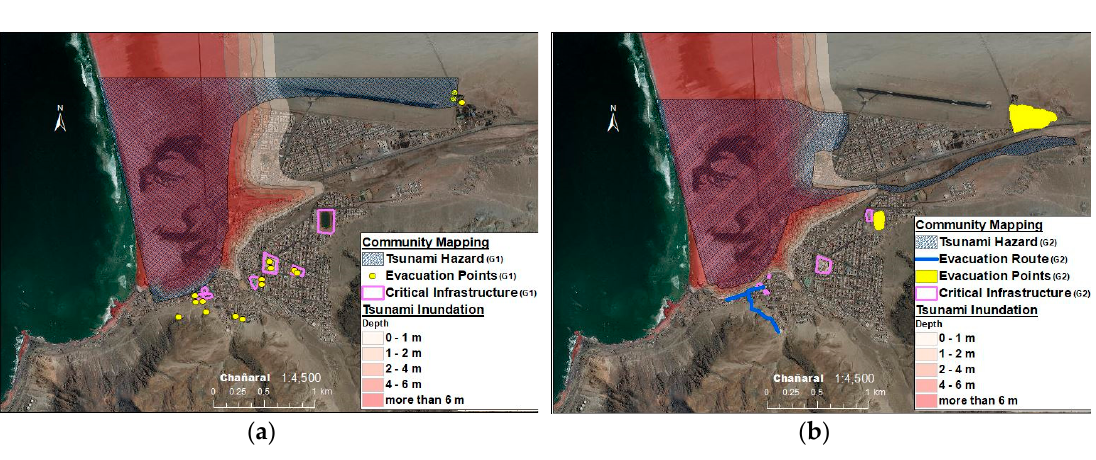
Figure 14. Results of the tsunami inundation and perceptions of tsunami flooding risk: ( a ) Group 1, ( b ) Group 2. Note that the location of critical infrastructure is also shown.